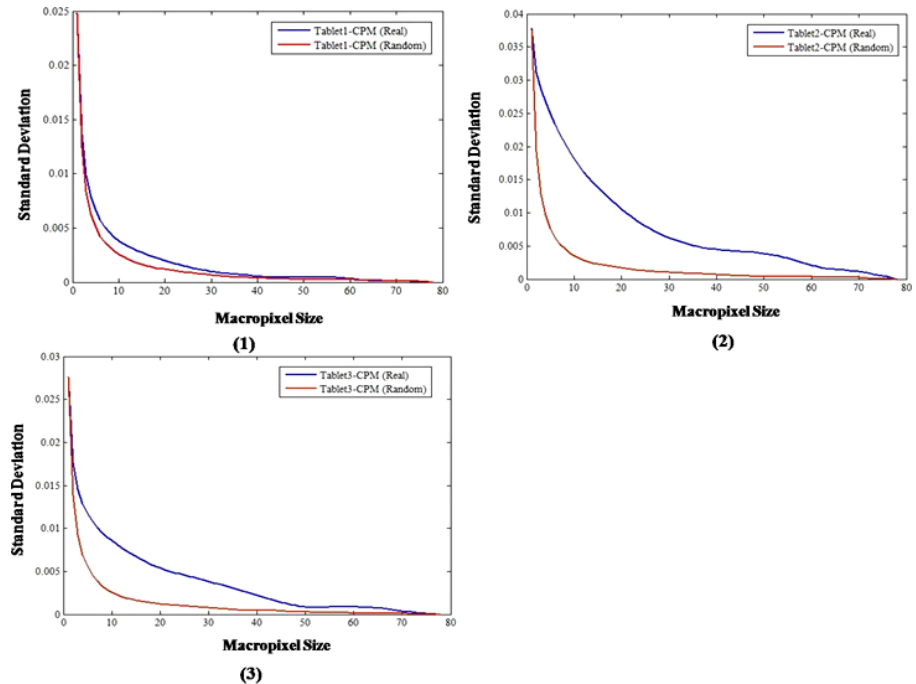
Fig. 4. Homogeneity curve of CPM distribution of three samples in prediction set. (1) Sample 1, (2) Sample 2, (3) Sample 3; DHI ¼ AU C real = AU C random